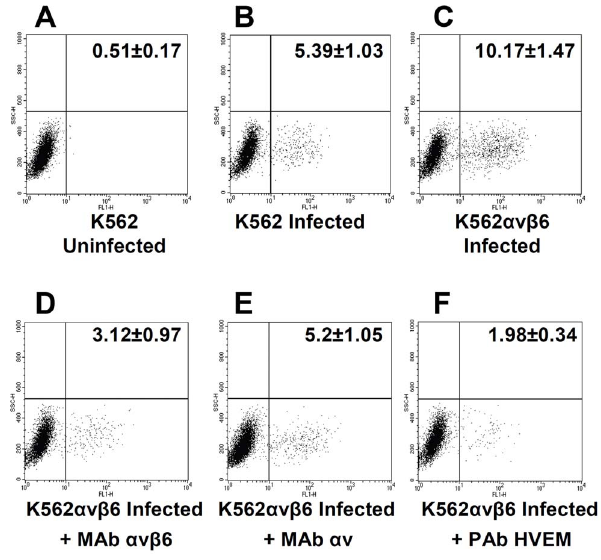
Figure 5. Gain of function experiment shows increase in infection with RLM5 in K562 cells following expression of a v b 6-integrin. (A, B) wt-K562 cells were uninfected (A) or infected with RLM5 (B). (C–F) K562 cells expressing a v b 6-integrin (K562 a v b 6 ) cells were infected with RLM5. (D–F) Inhibition of RLM5 infection in K562 a v b 6 cells exposed to MAb to a v b 6-integrin (D), or to a v-integrin (E) or to PAb to HVEM (F) for 1 h prior to infection with RLM5 in the same medium, and incubated with MAb-containing medium until harvest at 6 h after infection. The extent of infection was determined as percentage of cells expressing GFP. The figures reported in each panel represent percentage of cells in the lower right quadrant and represent the mean and standard deviation of four independent